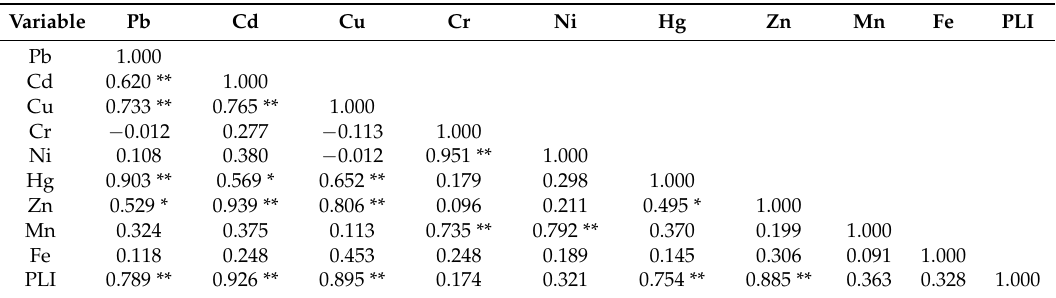
Table 6. Correlation matrix of heavy metals in the sediment samples for the HPS (Spearman correlation- rs ).